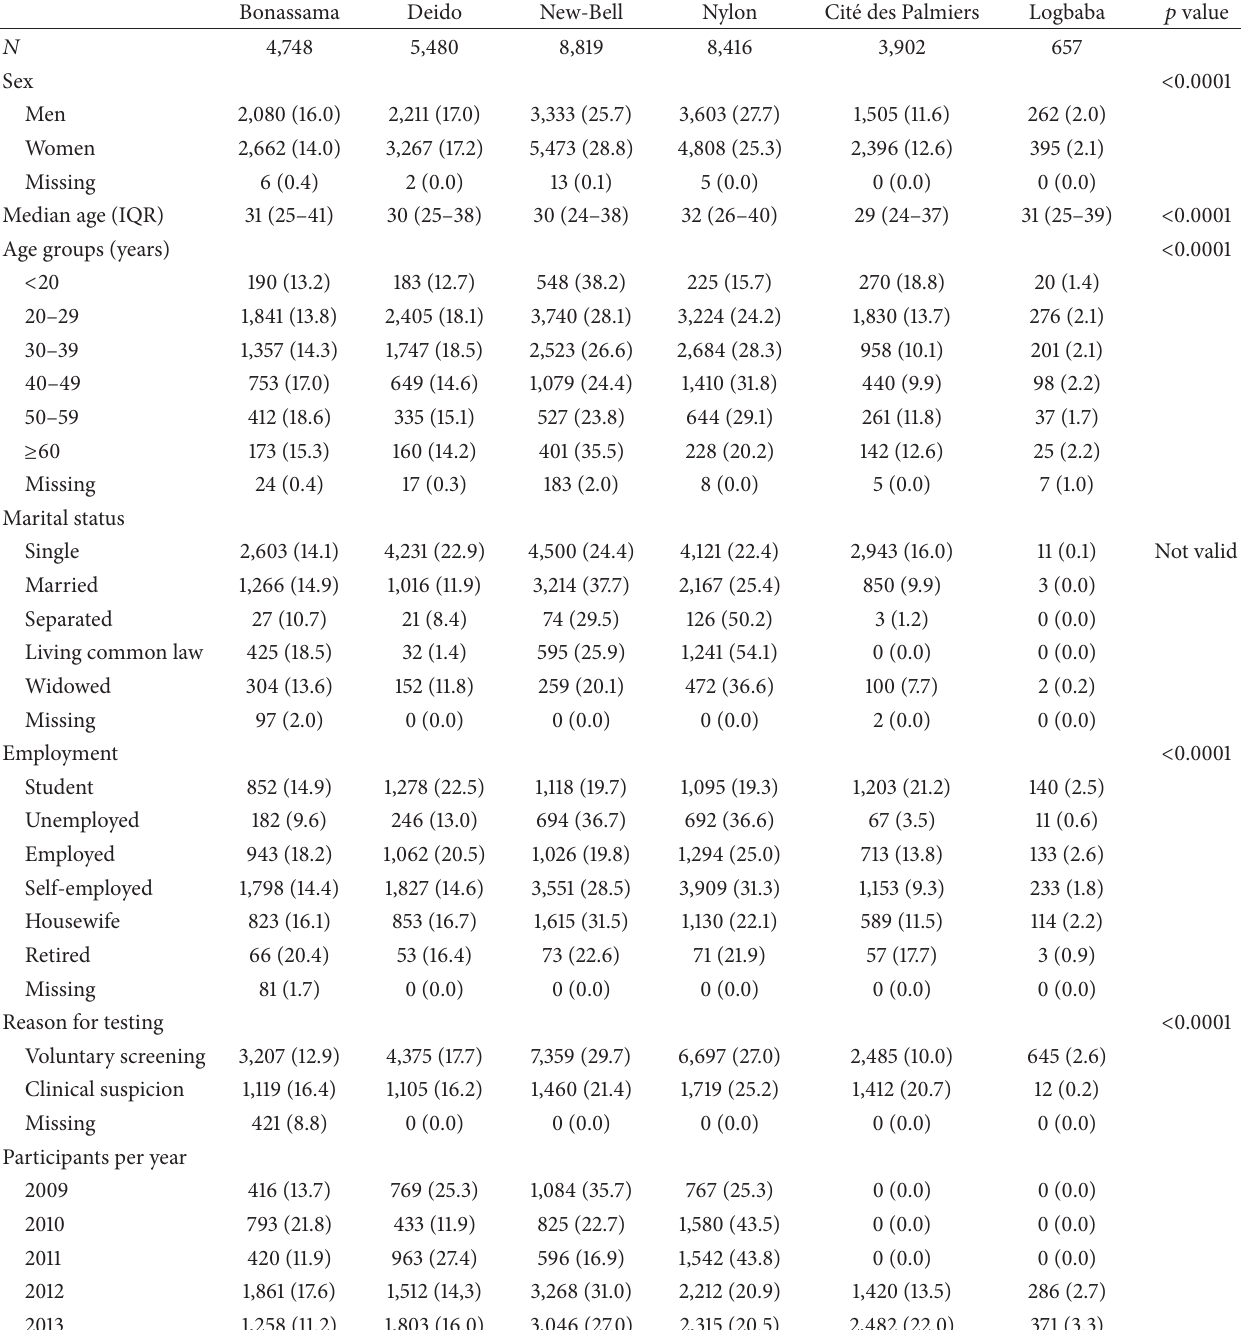
Table 1: Baseline characteristics of clients testing through Douala PVTCC from January 1, 2009, to December 31, 2013 (column percentages do not include missing